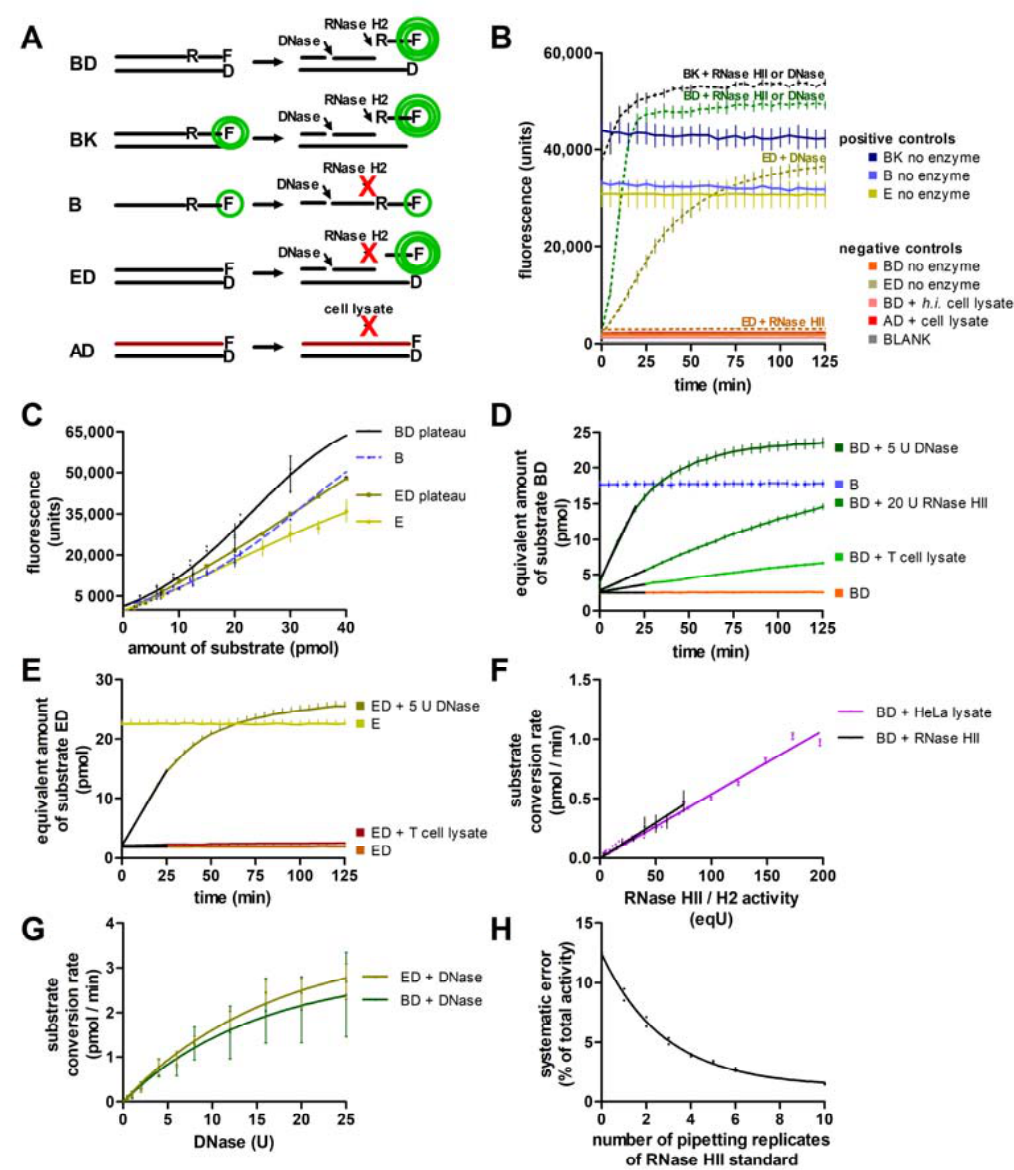
Figure 1. Assay principle and implementation of controls. ( A ) Substrate cleavage releases the fluorophore from the quencher. Details on substrates are shown in Materials and